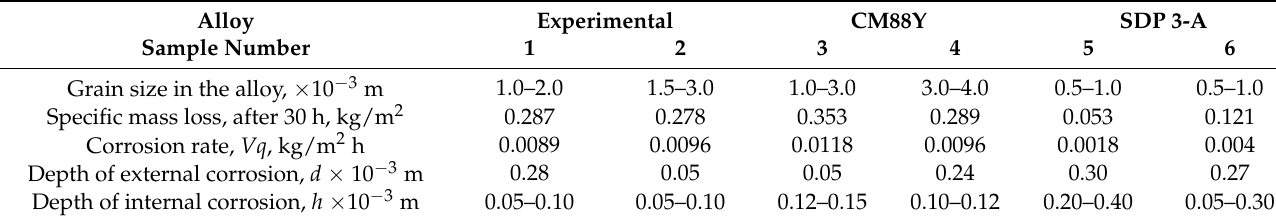
Figure 4. Macrostructure after tests (longitudinal section) of samples from the CM88Y alloy ( a ); experimental alloy ( b ); SDP3-A ( c ). Table 1. Results of high-temperature salt corrosion